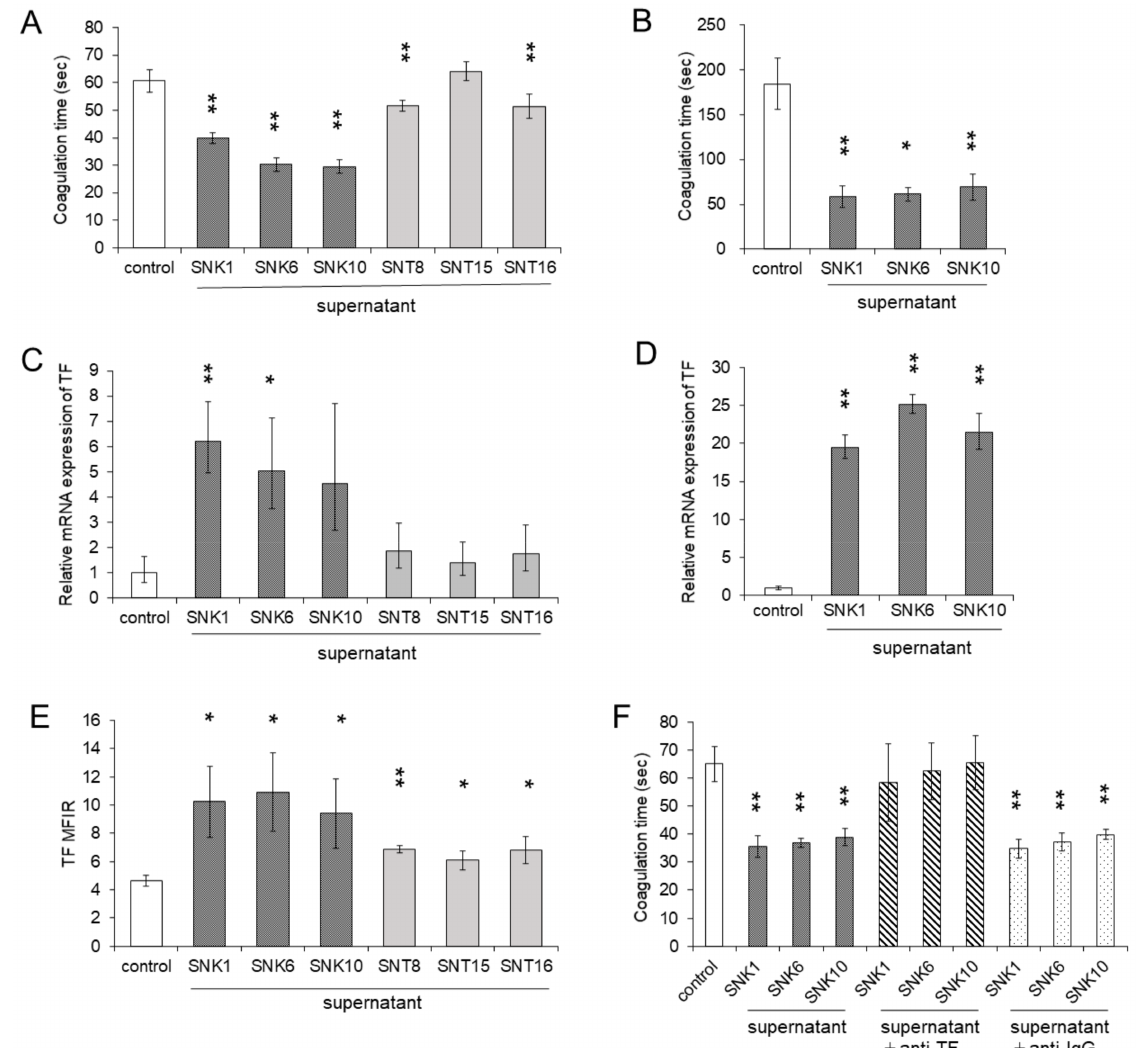
Figure 3. Procoagulant activity was enhanced by the supernatants of EBV-positive NK-cell lines. THP-1 cells and human monocytes were co-cultured with each supernatant of EBV-positive T- or NK- cell lines for 24 h. The same amount of culture media of EBV-positive T- or NK-cell lines was added as an untreated control. After the co-culture, the target cells were subjected to each assay. ( A ) The procoagulant activity (PCA) on THP-1 cells was measured by normal plasma-based recalcification time ( n = 6). The shortening of coagulation time indicates increased the PCA. ( B ) The PCA on human monocytes of three independent healthy donors was measured ( n = 3). ( C ) The mRNA expression of the tissue factor (TF) in THP-1 cells was examined by qRT-PCR ( n = 3). The expression was normalized to GAPDH mRNA. ( D ) The mRNA expression of TF in human monocytes of three independent healthy donors was measured ( n = 3). ( E ) The cell surface TF antigen on THP-1 cells was analyzed by flow cytometry using an antibody to TF or isotype-matched control. The mean fluorescent intensity of TF was normalized by that of isotype-matched control and expressed as MFIR ( n = 4). ( F ) To investigate the effects of cell surface TF on PCA, THP-1 cells were treated with mouse monoclonal anti-human TF antibody or the same amount of irrelevant IgG. After the treatment of antibody, the cell surface PCA was assessed ( n = 4). The data are shown as the mean ± SD. Statistical analyses were assessed and are indicated as * p < 0.05 and ** p < 0.01 compared to the